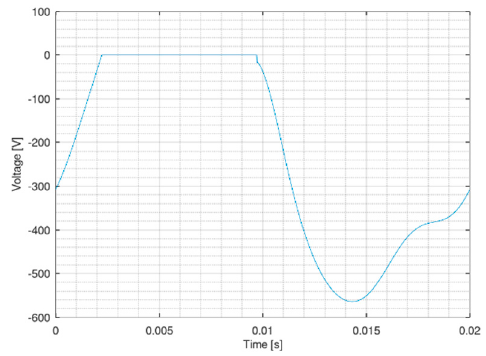
Figure 6. Voltage of the nonlinear voltage source in the time domain.